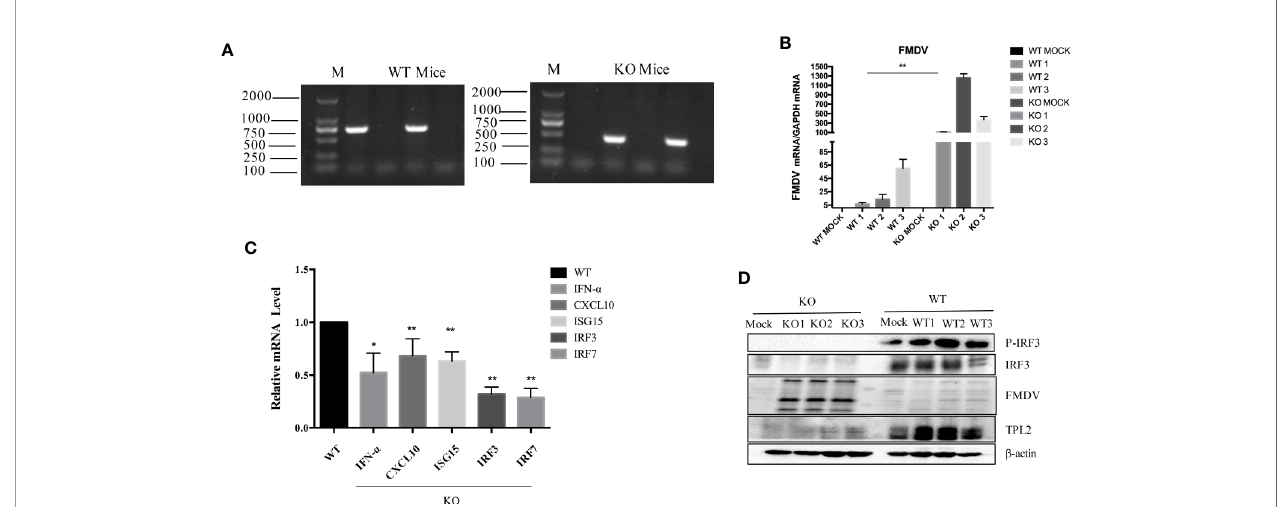
FIGURE 2 | TPL2 is essential to inhibit FMD virus (FMDV) replication in vivo . (A) Primers targeting TPL2 knockout region. DNA from WT and Tpl2 - /- suckling mice was extracted. After the PCR procedure, the expected size of PCR fragments appeared in the WT and Tpl2 - /- group. (B) WT and Tpl2 - /- suckling mice were used to evaluate FMDV-associated gene transcription by real-time qPCR (qRT-PCR). (C) Total RNA was extracted from the carcasses of WT and Tpl2 - /- suckling mice to evaluate transcription of genes encoding IFN- a , MX2 and CXCL10, IRF3, and IRF7 by qRT-PCR. (D) Protein in lysates extracted from carcasses of WT and Tpl2 - /- suckling mice were used to evaluate phosphorylation of IRF3 and infection with FMDV(n = 5 per group).